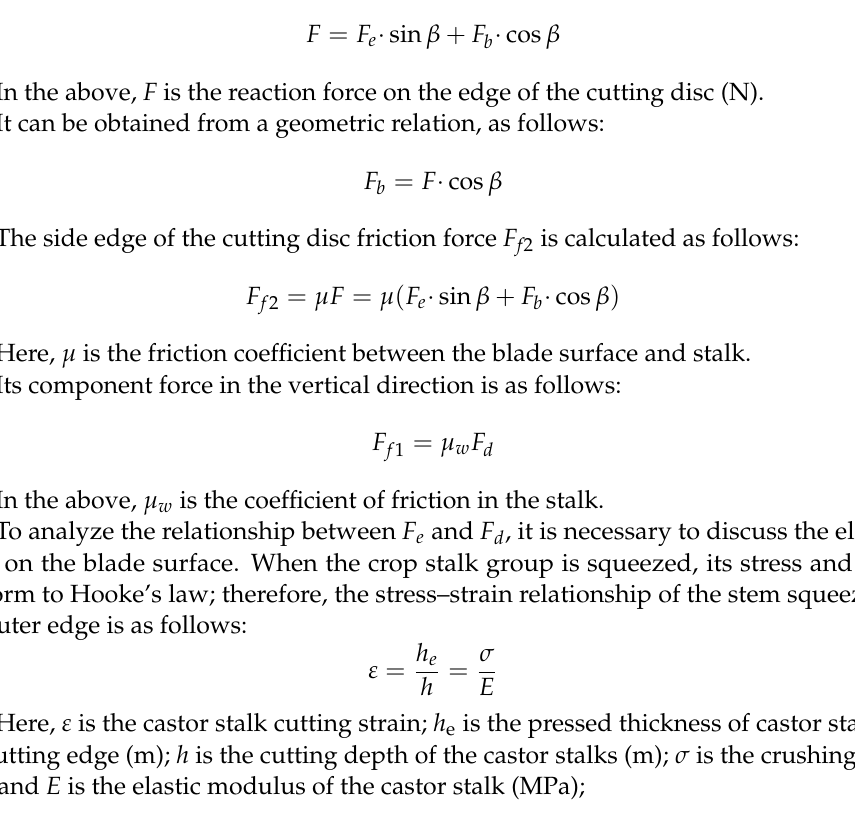
Here, ∆ is the blade blunt width (m); l is the blade cutting length (m); and σ c is the yield strength during cutting